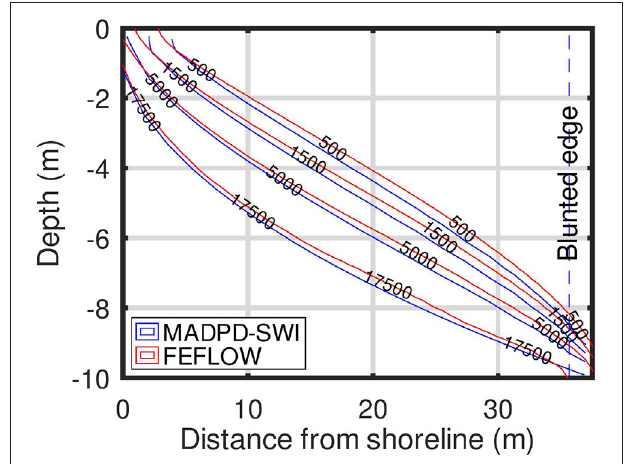
FIGURE 3 | Lines of constant salinity [ppm TDS] of the FEFLOW and 2D-MADPD-SWI solutions for α = 10.